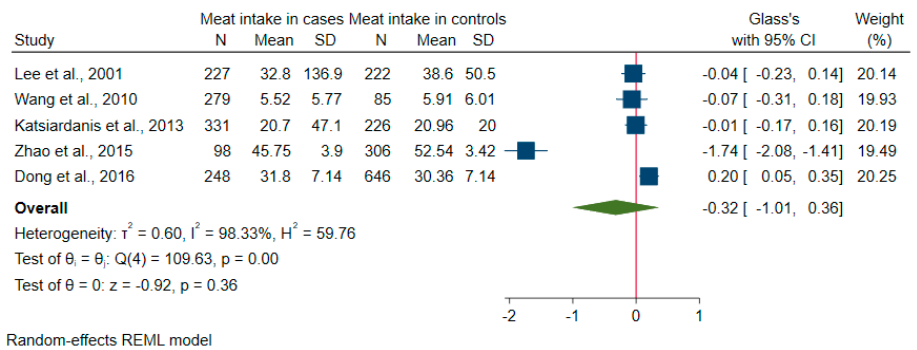
Figure 2. Forest plot of studies with continuous amounts of meat consumed between cases with cognitive impairment and controls for meta-analysis.